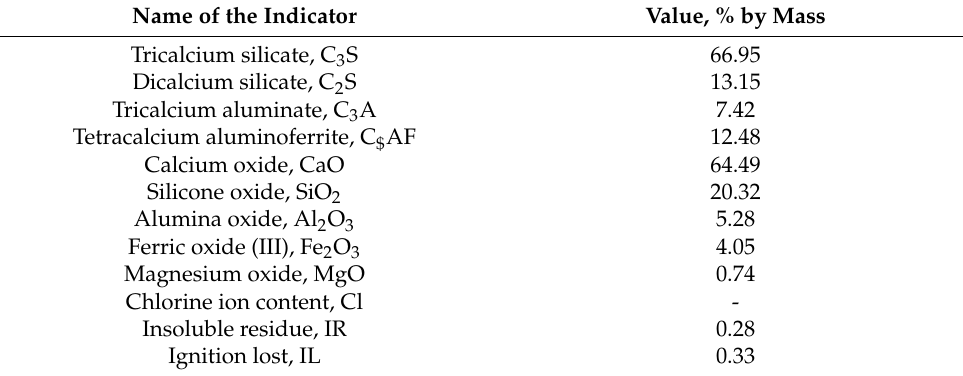
Table 1. Chemical and mineralogy composition of the CEM II/AS 42.5.